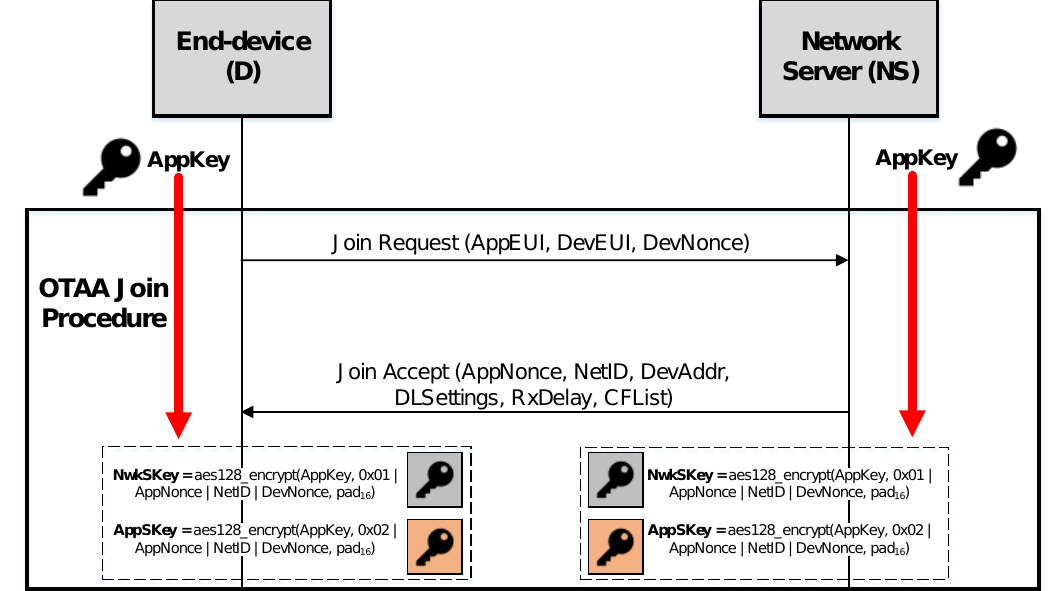
Figure 1. Overview of the OTAA join